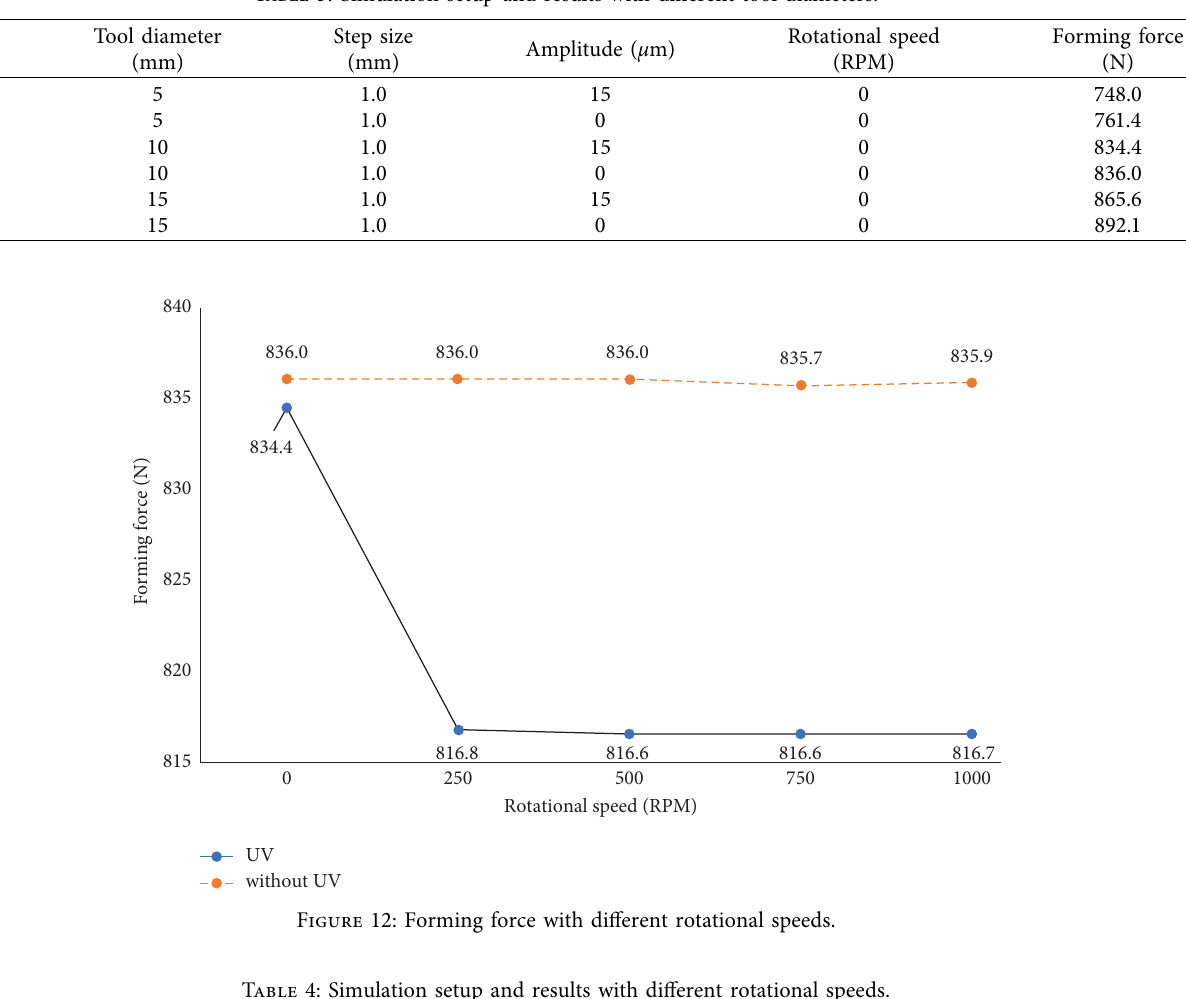
Table 3: Simulation setup and results with diferent tool diameters.